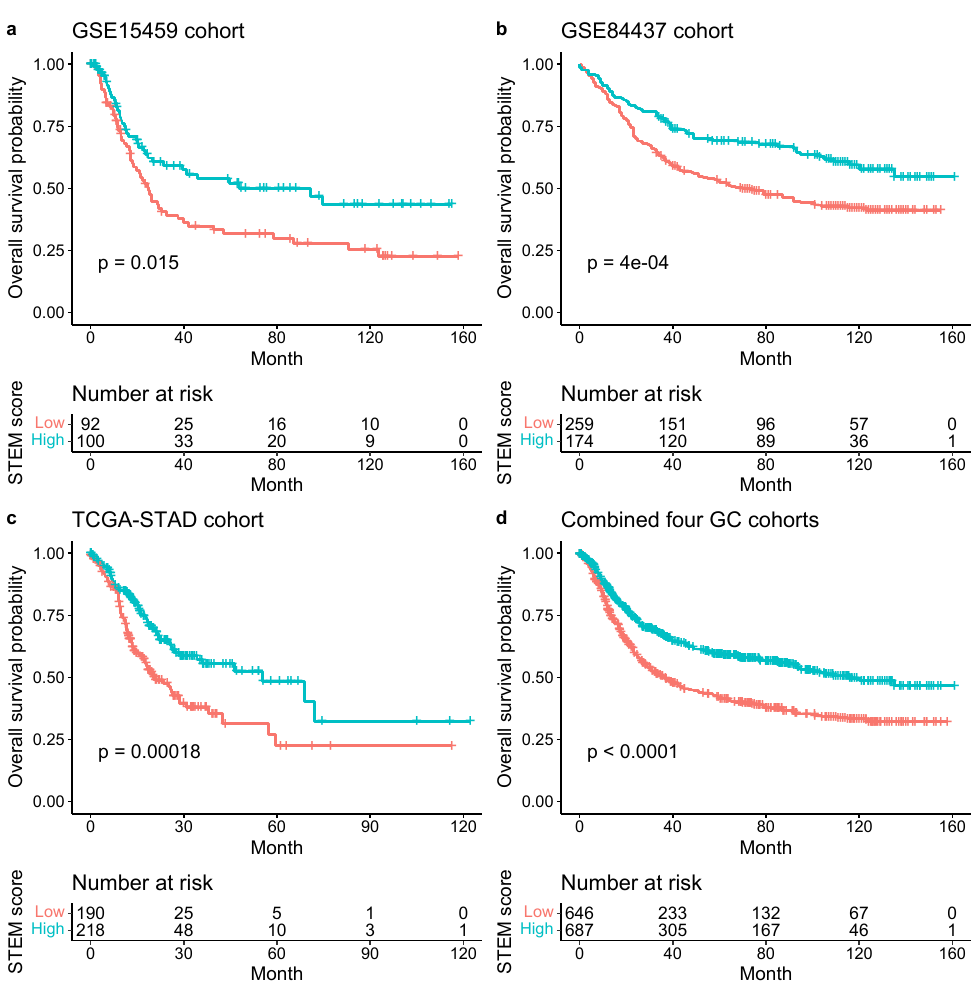
Figure 12. Kaplan–Meier survival curves for the patients with low vs. high STEM scores in the ACRG cohort.